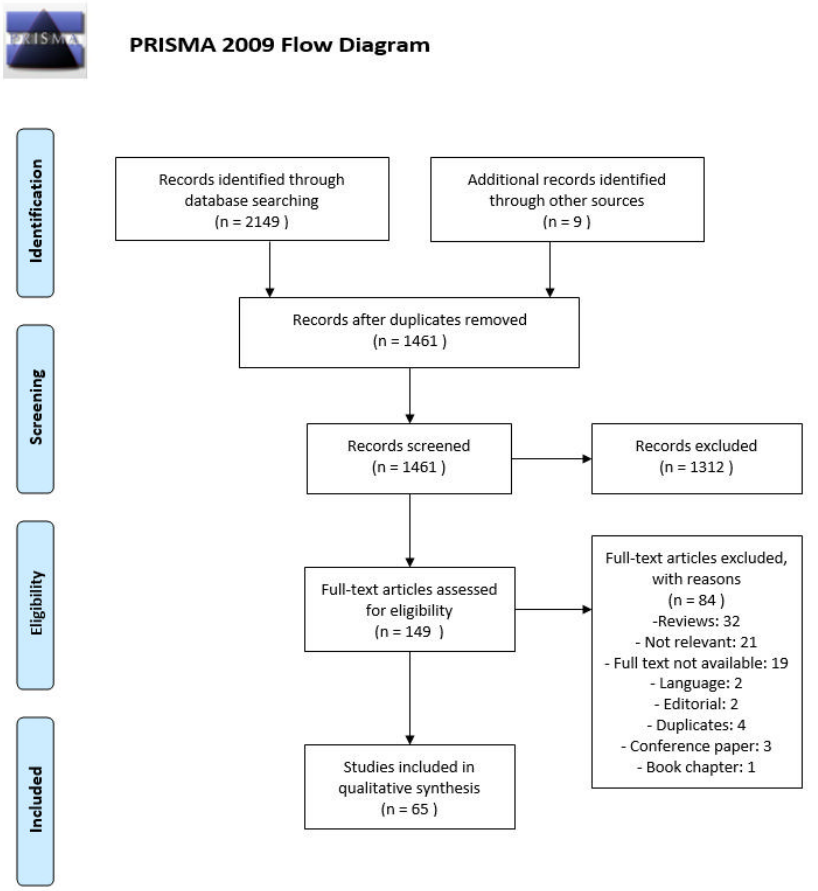
Figure 1. Preferred Reporting Items for Systematic Reviews and Meta-Analyses (PRISMA) study flow chart.